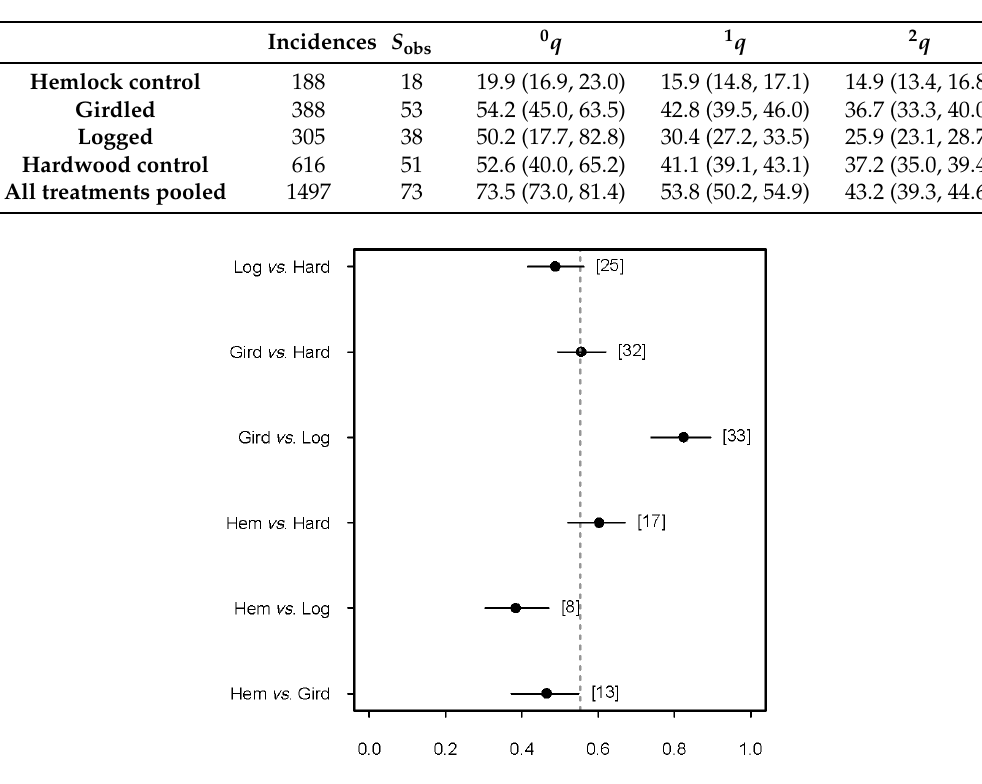
Table 1. Species richness (all years pooled) in the Harvard Forest Hemlock Removal Experiment.